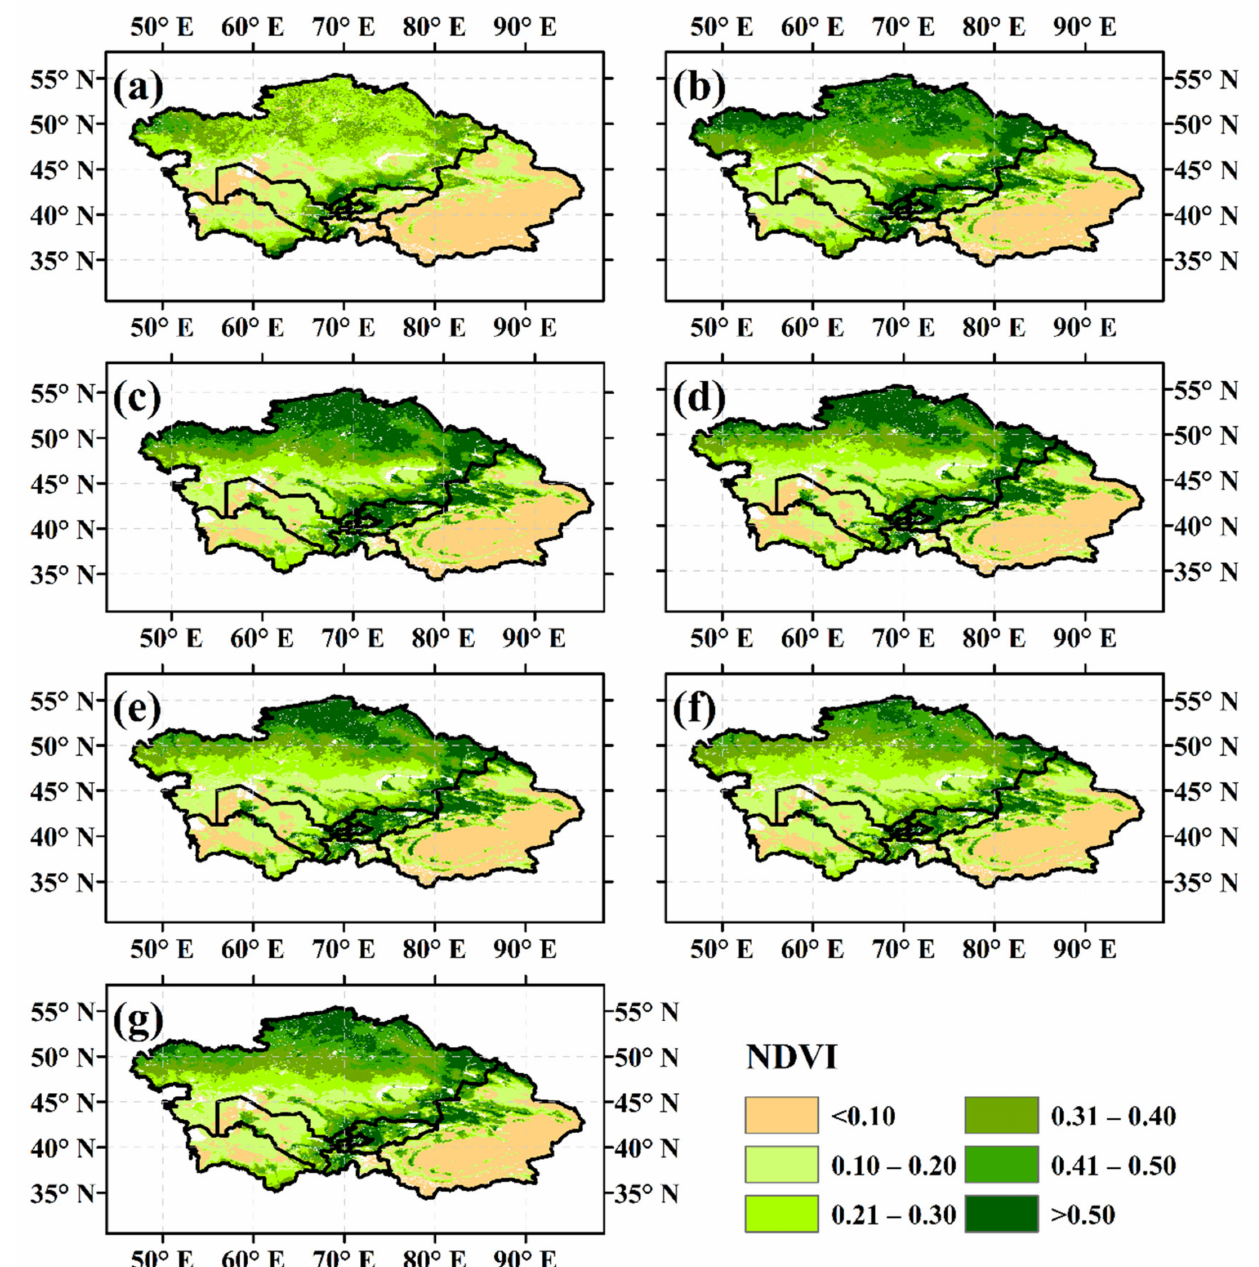
Figure 4. Multi-year mean NDVI from 1982 to 2015 in April ( a ), May ( b ), June ( c ), July ( d ), August ( e ), September ( f ), and growing season ( g ). The blank area is water body, snow and ice, or urban